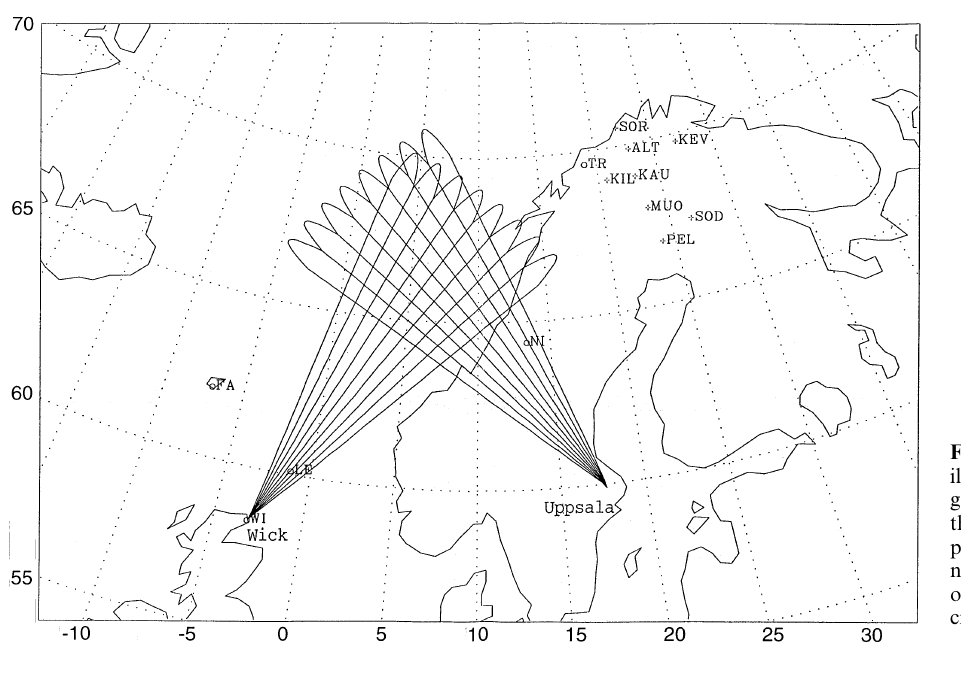
Fig. 1. A schematic diagram to illustrate the location in geo- graphic latitude and longitude of the SABRE field of view, the position of the BGS mag- netometers ( (cid:67) ) and the stations of the EISCAT magnetometer cross ( #